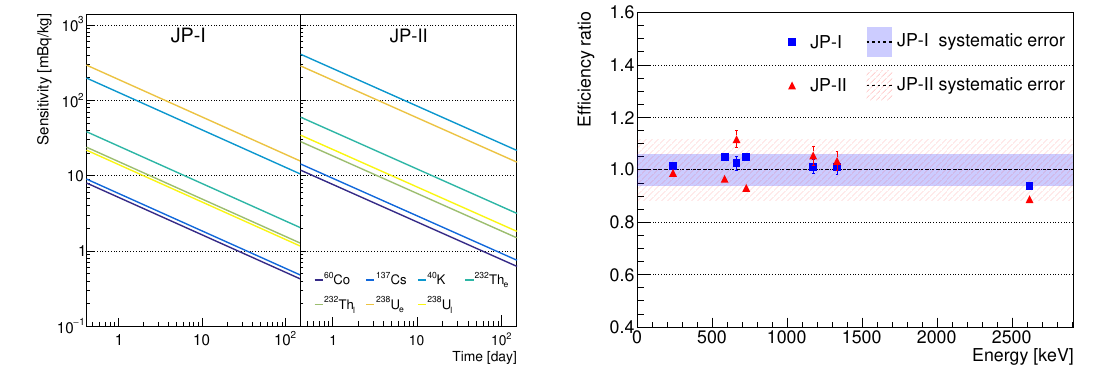
Figure 3. Sensitivity of JP-I and JP-II HPGe detectors for a PTFE sample.